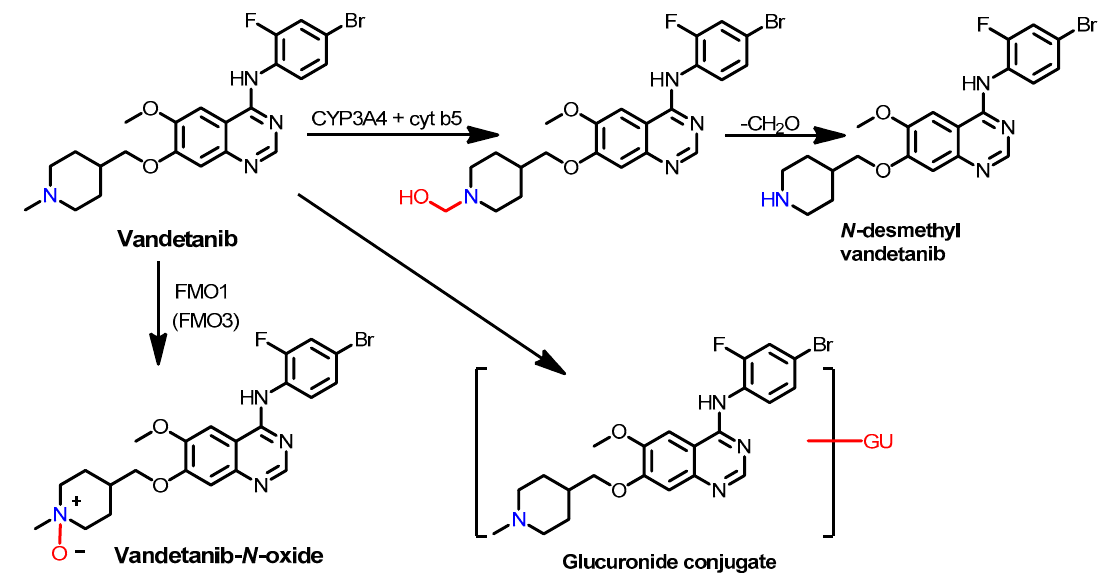
Figure 65. Proposed metabolic pathways of vandetanib in healthy